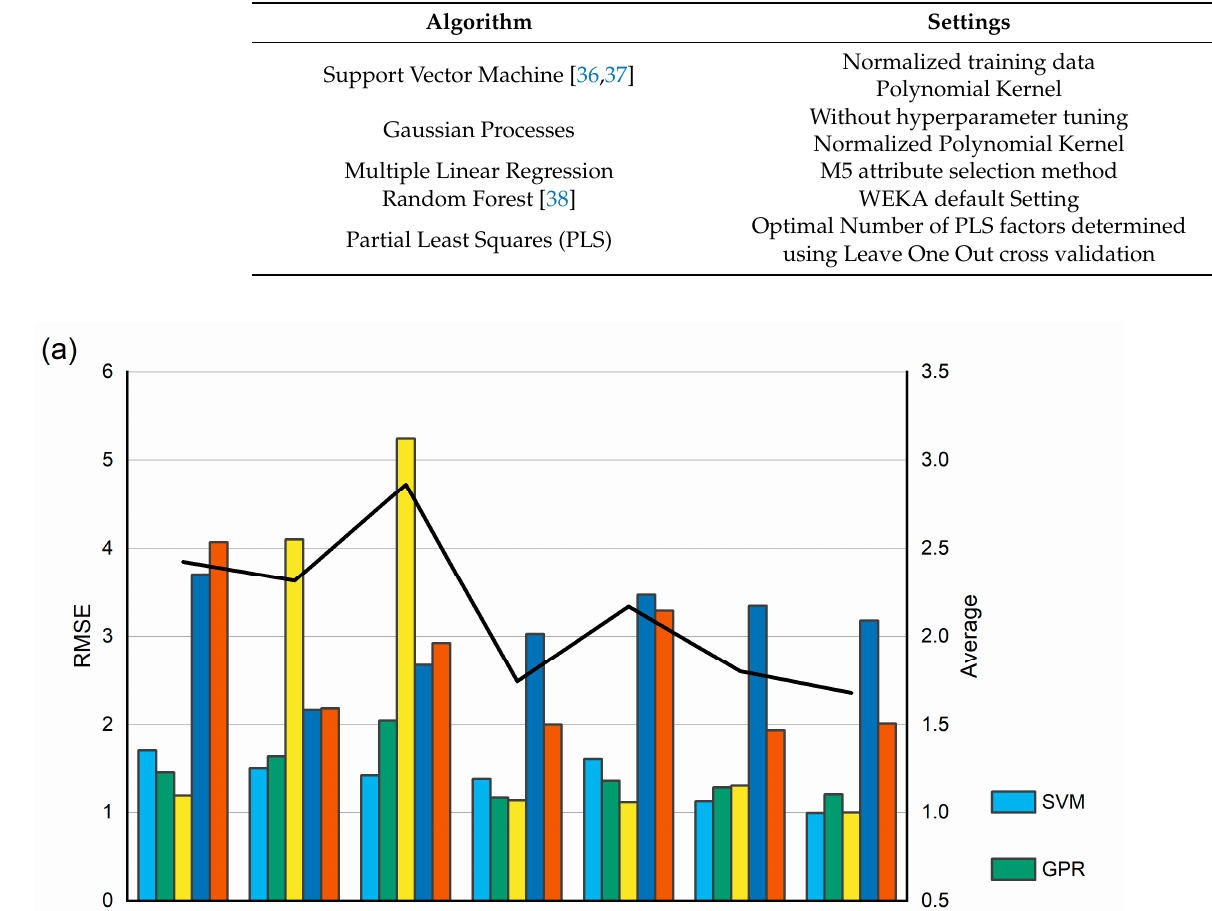
Table 2. Regression Algorithms and their settings.